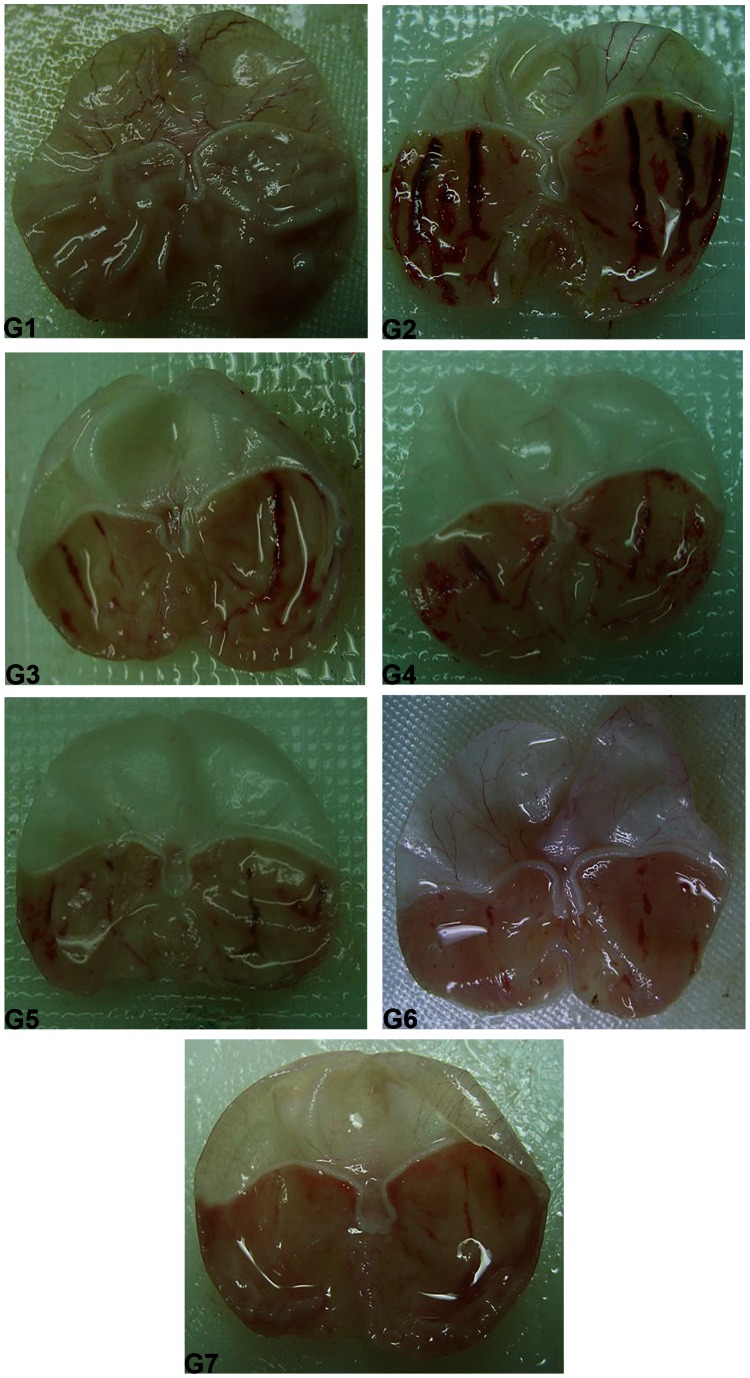
The effect of P. speciosa on the macroscopic appearance of the gastric mucosa in ethanol-induced gastric mucosal lesions in rats.(G1) (Normal control group); (G2) (Ulcer control group); (G3) (Omeprazole); (G4) (50 mg/kg), (G5) (100 mg/kg), (G6) (200 mg/kg), (G7) (400 mg/kg) Parkia speciosa extract.